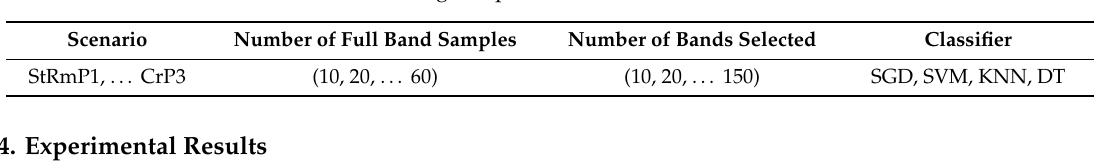
Table 2. Training setup for all scenarios and